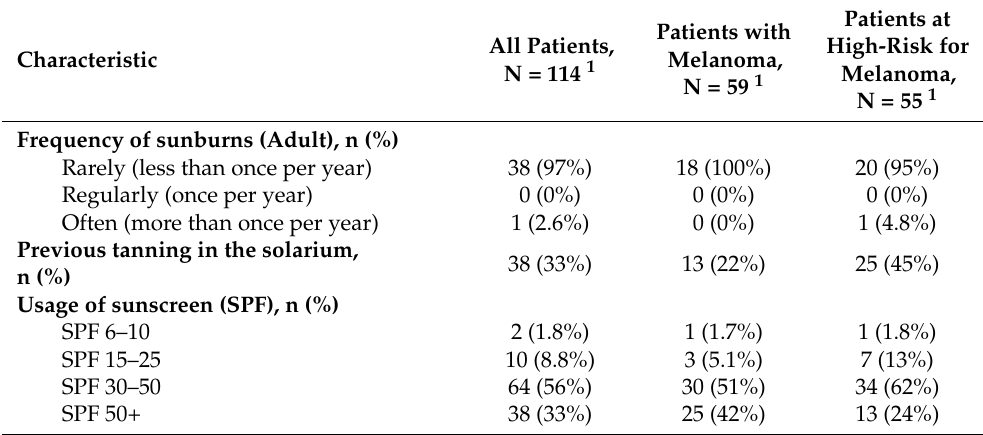
Figure 2. Comparison of risk assessments with the highest rate of suspected melanoma cases by the smartphone app (n = 1204).